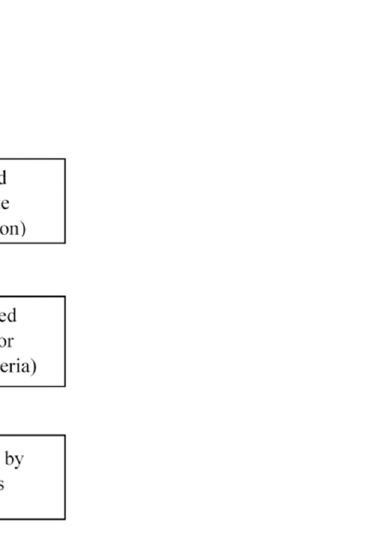
Fig 1. Flowchart of the process of retrospective review of medical